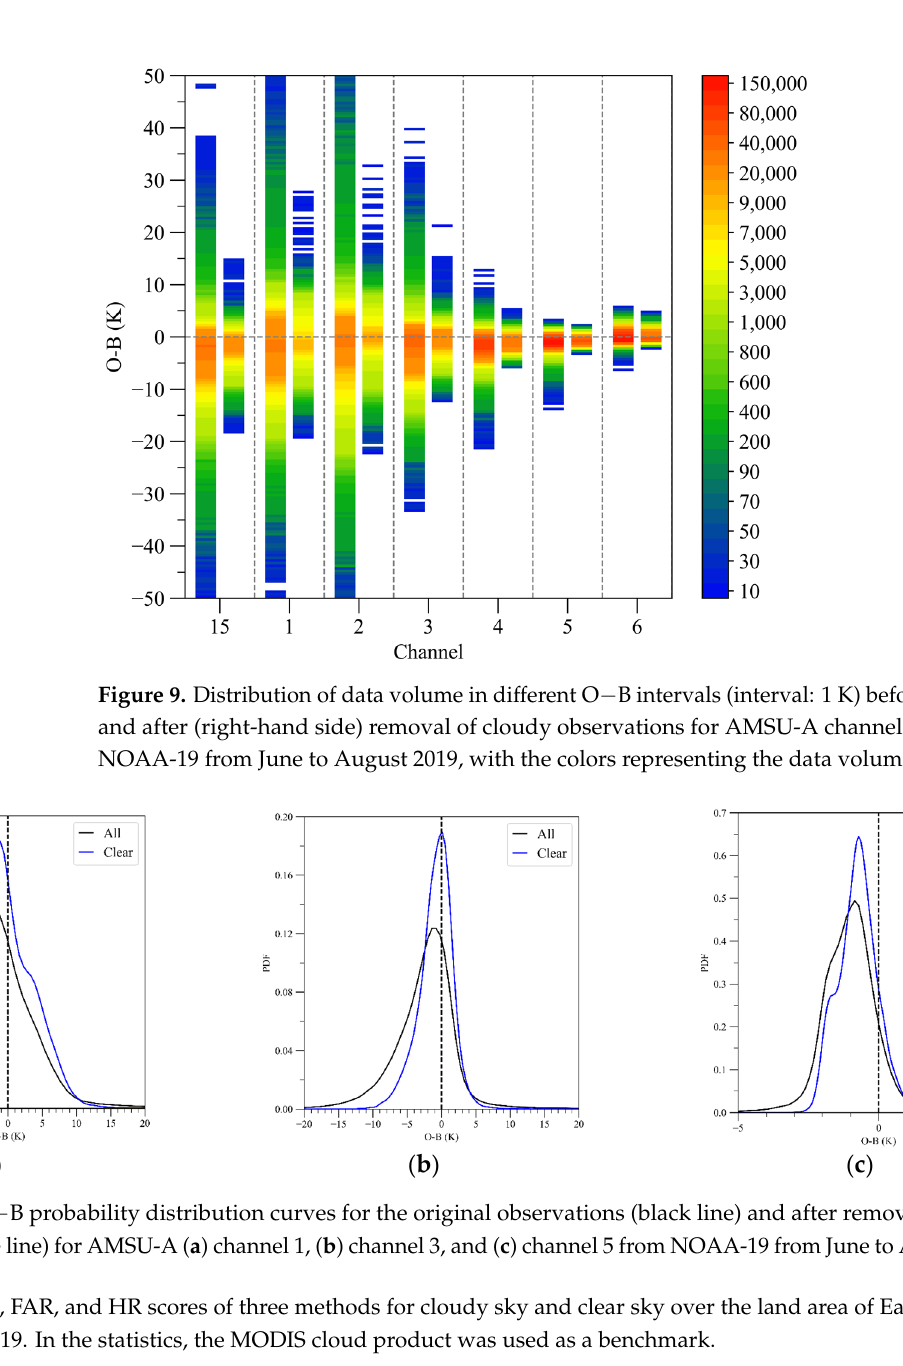
Figure 8. As in Figure 7 but with the black circles representing cloudy FOVs detected by both cloud detection methods, the blue circles denoting cloudy FOVs detected by only the new method, and the cyan circles showing the cloudy FOVs detected by only the old method, at ( a ) 0600 UTC 26 June and ( b ) 0600 UTC 28 June 2019.